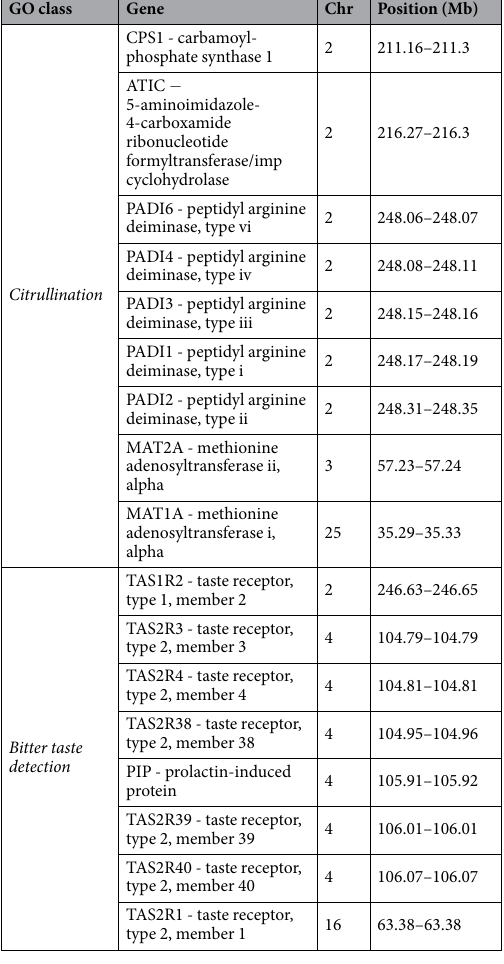
Table 3. Genes with signals of adaptive introgression from mouflon into domestic sheep. Genes identified by the CIWI approach, involved in either citrullination or bitter-taste detection (GO class). The chromosome (Chr) and physical position are